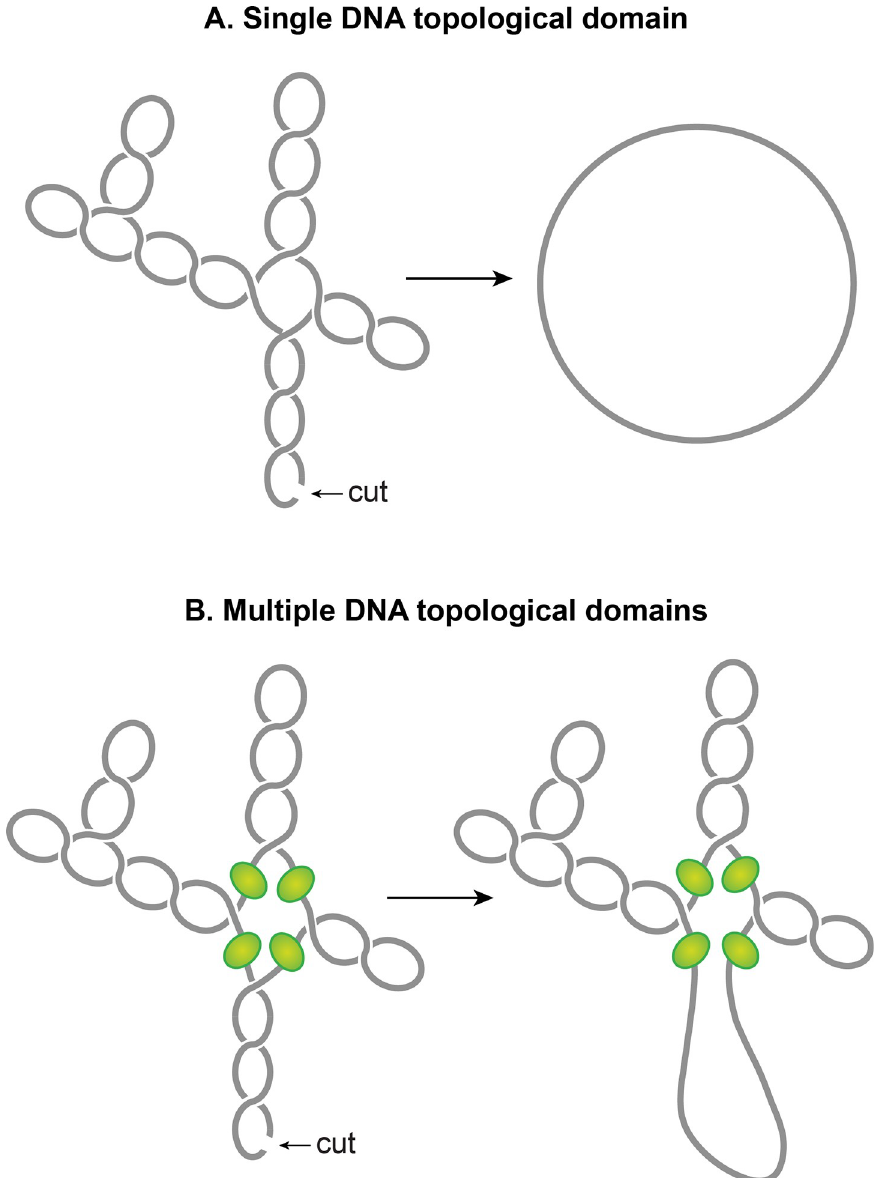
Fig 7. The chromosomal DNA within the nucleoid is segregated into independent supercoiled topological domains. A. An illustration of a single topological domain of a supercoiled DNA. A single double-stranded cut anywhere would be sufficient to relax the supercoiling tension of the entire domain. B. An illustration of multiple topological domains in a supercoiled DNA molecule. A presence of supercoiling-diffusion barriers segregates a supercoiled DNA molecule into multiple topological domains. Hypothetical supercoiling diffusion barriers are represented as green spheres. As a result, a single double-stranded cut will only relax one topological domain and not the others. Plectonemic supercoils of DNA within the E . coli nucleoid are organized into several topological domains, but only four domains with a different number of supercoils are shown for